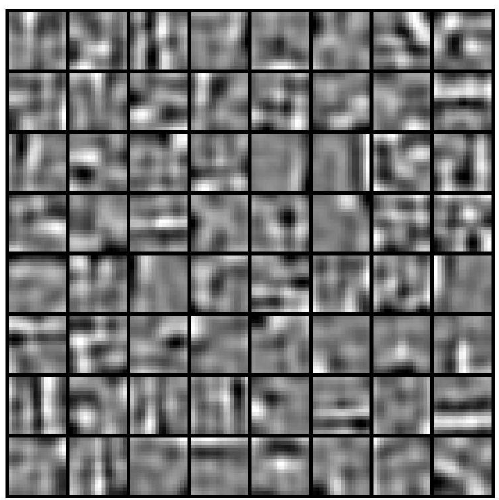
Figure. 6 Learned encoders of autoencoders for setting 3) P = 16 , K = 16 , H=64 .